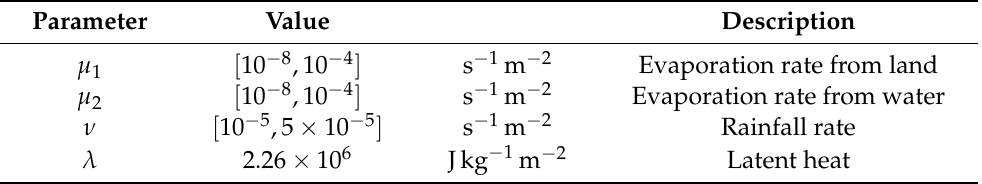
Table 7. Evaporation rate, rainfall rate, and latent heat of evaporation and condensation.